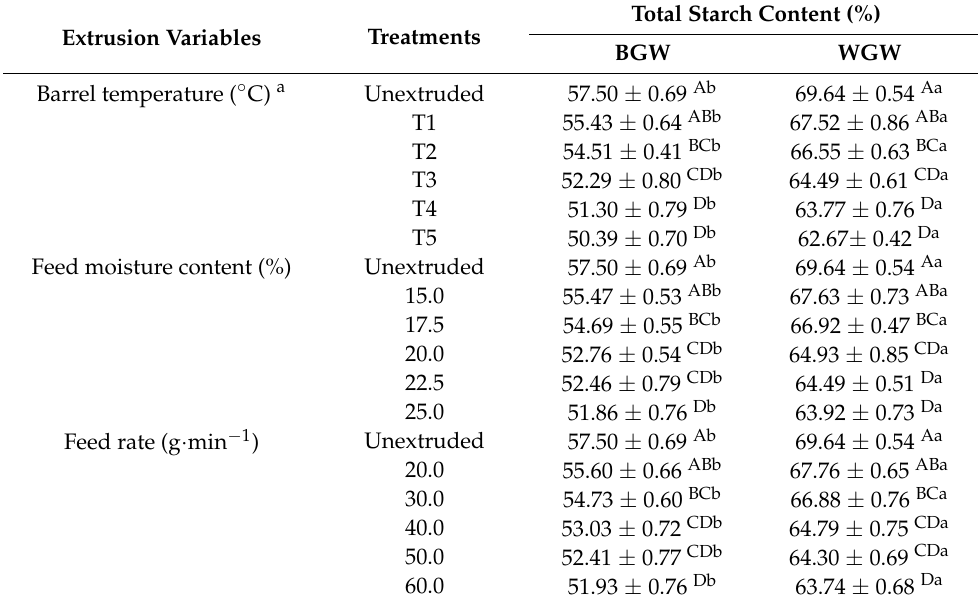
Table 5. Effect of the extrusion variables on the total starch content of the wheat extrudates. Extrusion